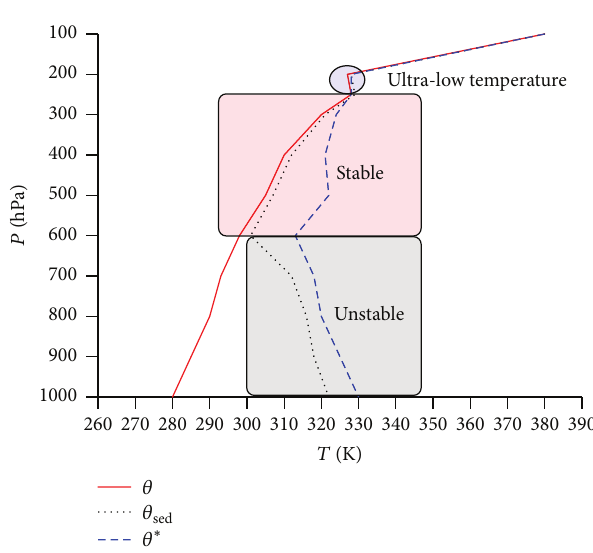
Figure 1: 𝑉 - 3𝜃 graph. If the angle between the curve and the 𝑥 - axis is approximate to or bigger than 90 ∘ , the data indicate that the atmosphere in this area is distributed extremely homogeneously and that this area is a thermally unstable area (gray area). Otherwise, the areaisastablearea(pinkarea).Iftheunstableareaislocatedbetween 300and100 hPa,thephenomenonofultra-lowtemperatureappears.